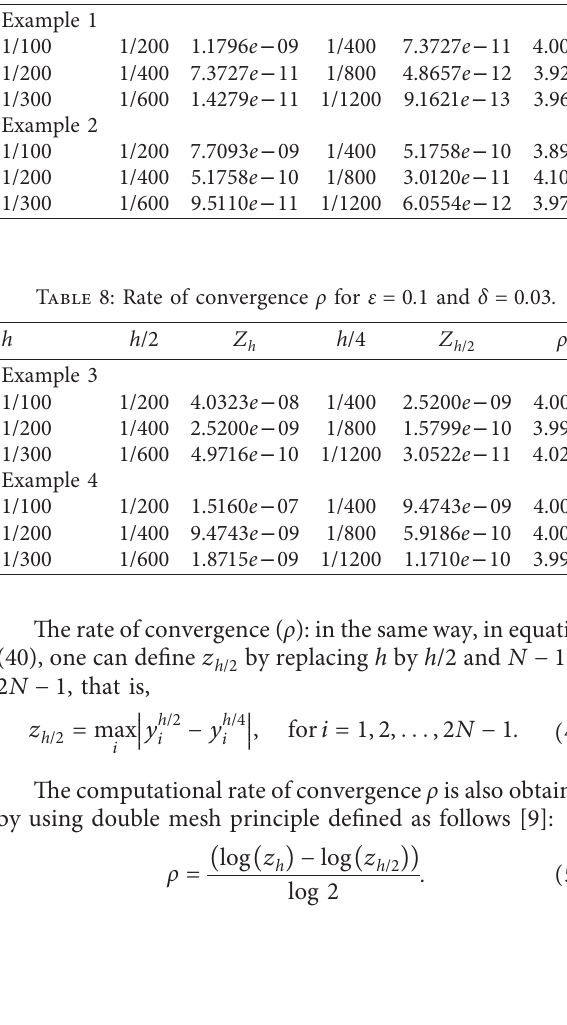
Figure 5: The point-wise absolute errors of Example 2 for different values of mesh size h, ε � 2 − 8 , and δ � 0 . 5 ε .